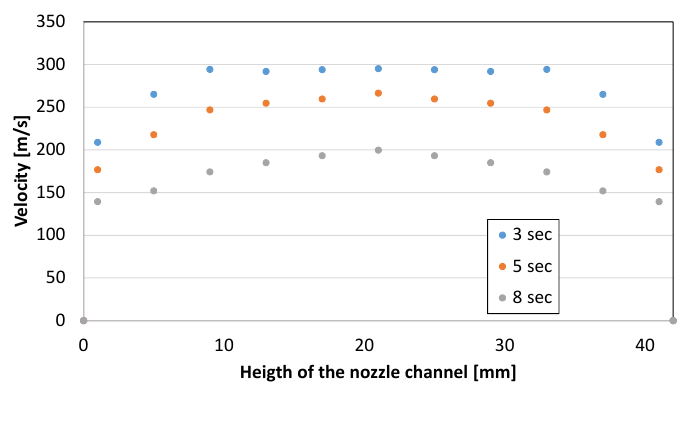
Figure 8. Profile of the velocity in the nozzle channel. The profile was processed for the three time position after the measurement sequence start.